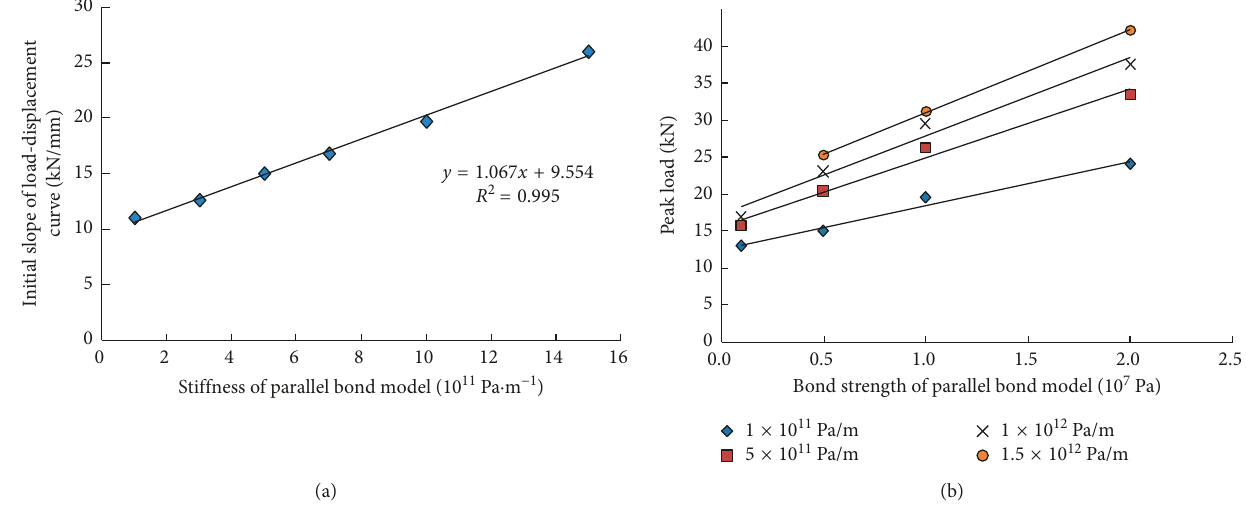
Figure 12: Parameters of the 2D parallel bond model. (a) Original slope of the splitting test curve versus stiffness. (b) Peak load of the splitting test versus bond